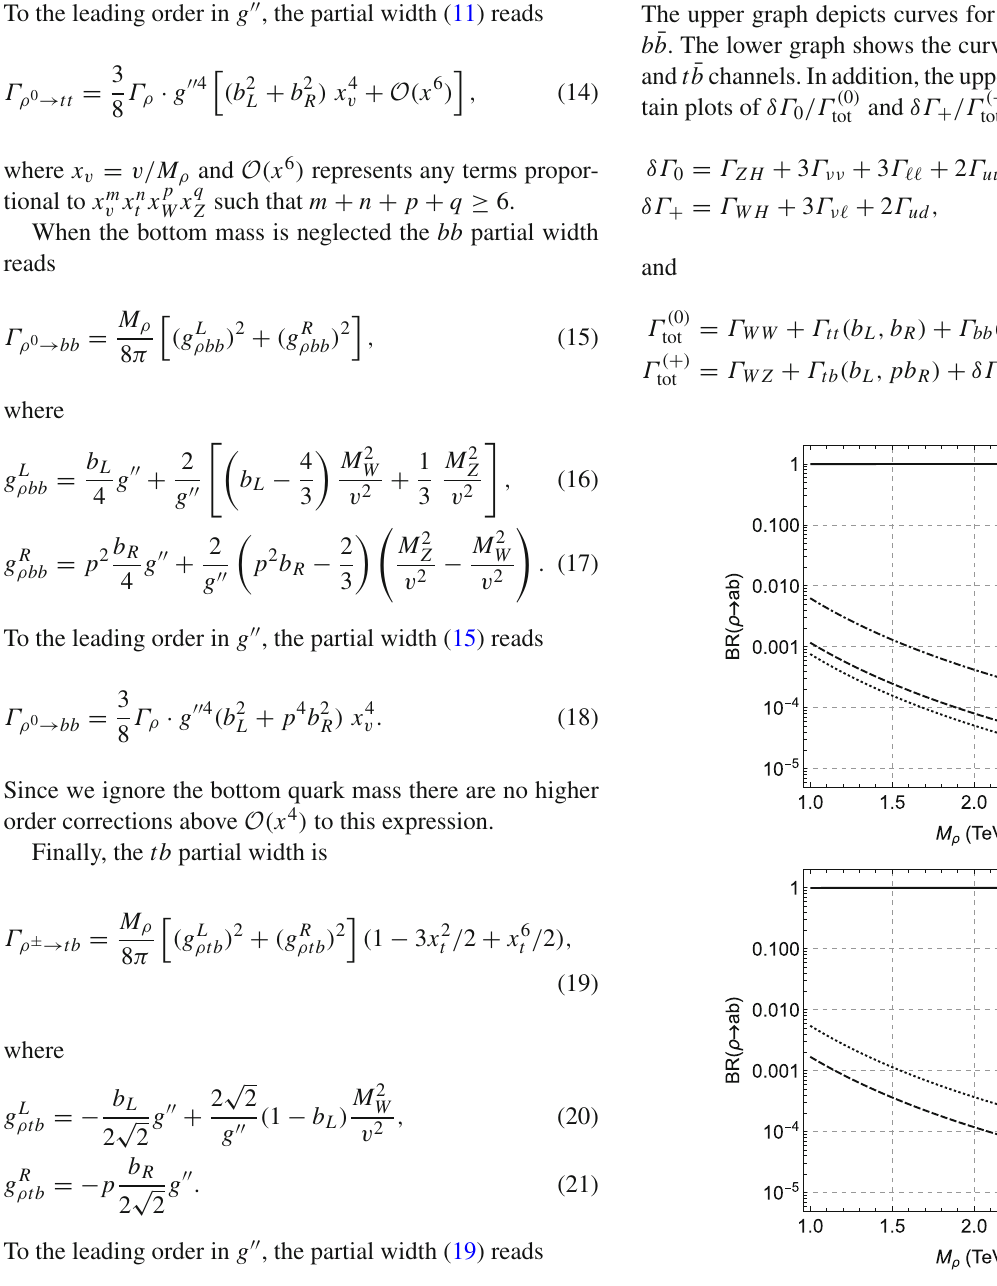
Fig. 2 The branching ratios of the neutral (top) and charged (bottom) vector resonances as functions of the resonance mass when there are no direct interactions of the resonance triplet with the top and bottom